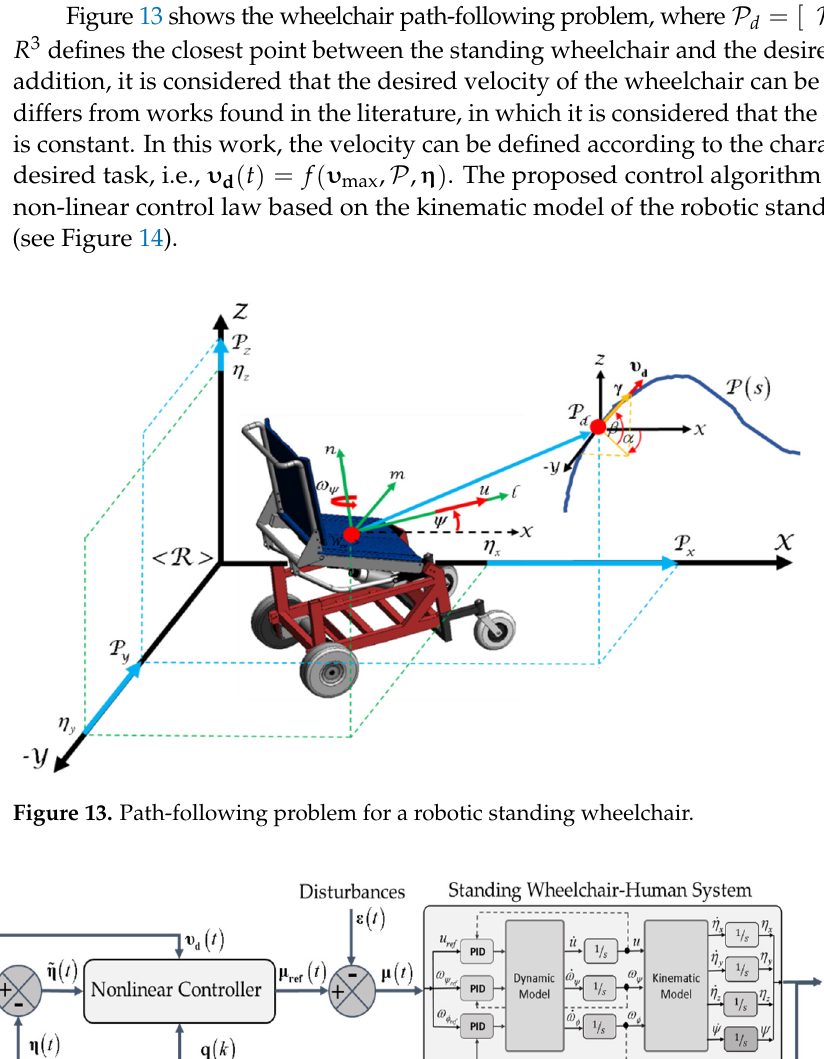
14 of 32 Figure 12. Publisher/subscriber of the shared memories. 6. Control Algorithm Design The proposed control algorithm for the execution of rehabilitation and autonomous